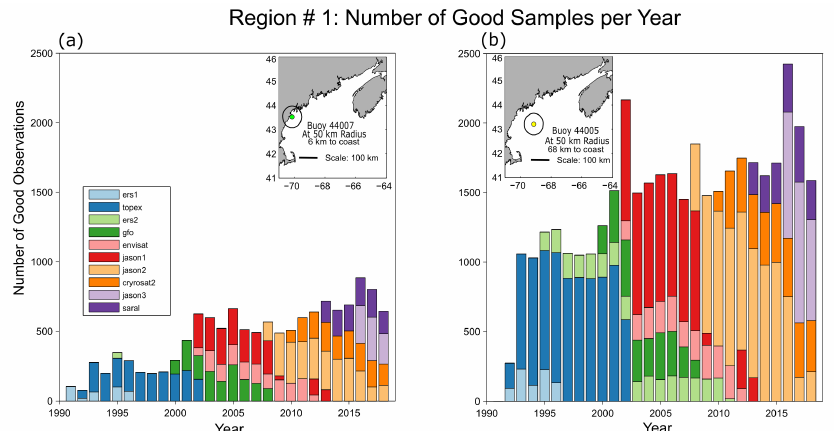
Figure 5. Total number of good (qual_flag = 3) Hs observations per year in region #1, ( a ) at nearshore